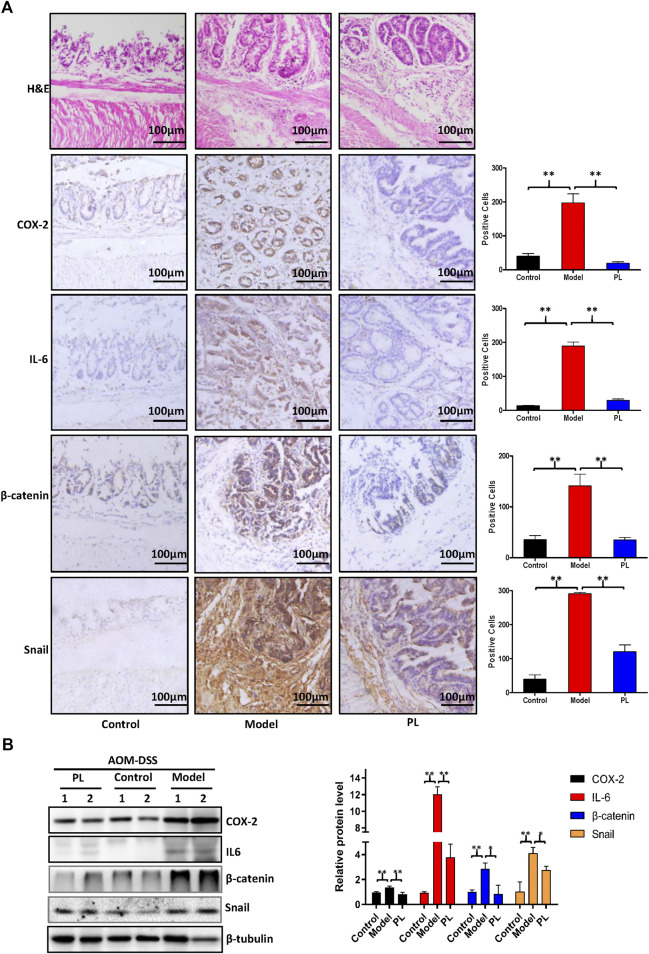
Piperlongumine (PL) inhibits the protein expressions of cyclooxygenase-2 (COX-2), interleukin-6 (IL-6), β-catenin, and snail in acute colitis and azoxymethane (AOM)/DSS-induced colorectal cancer mouse models (A) Colon sections were stained with H&E and the indicated antibodies (B) The protein expression was examined by Western blot with the indicated antibodies after lysing colon tissues from two mice of each group, and β-tubulin was used as loading control. The representative results and quantified data are shown. Note: Control, no treated group; model, AOM/DSS-treated group; PL, AOM/DSS in combination with PL-treated group. *p < 0.05, and **p < 0.01 vs. corresponding group.